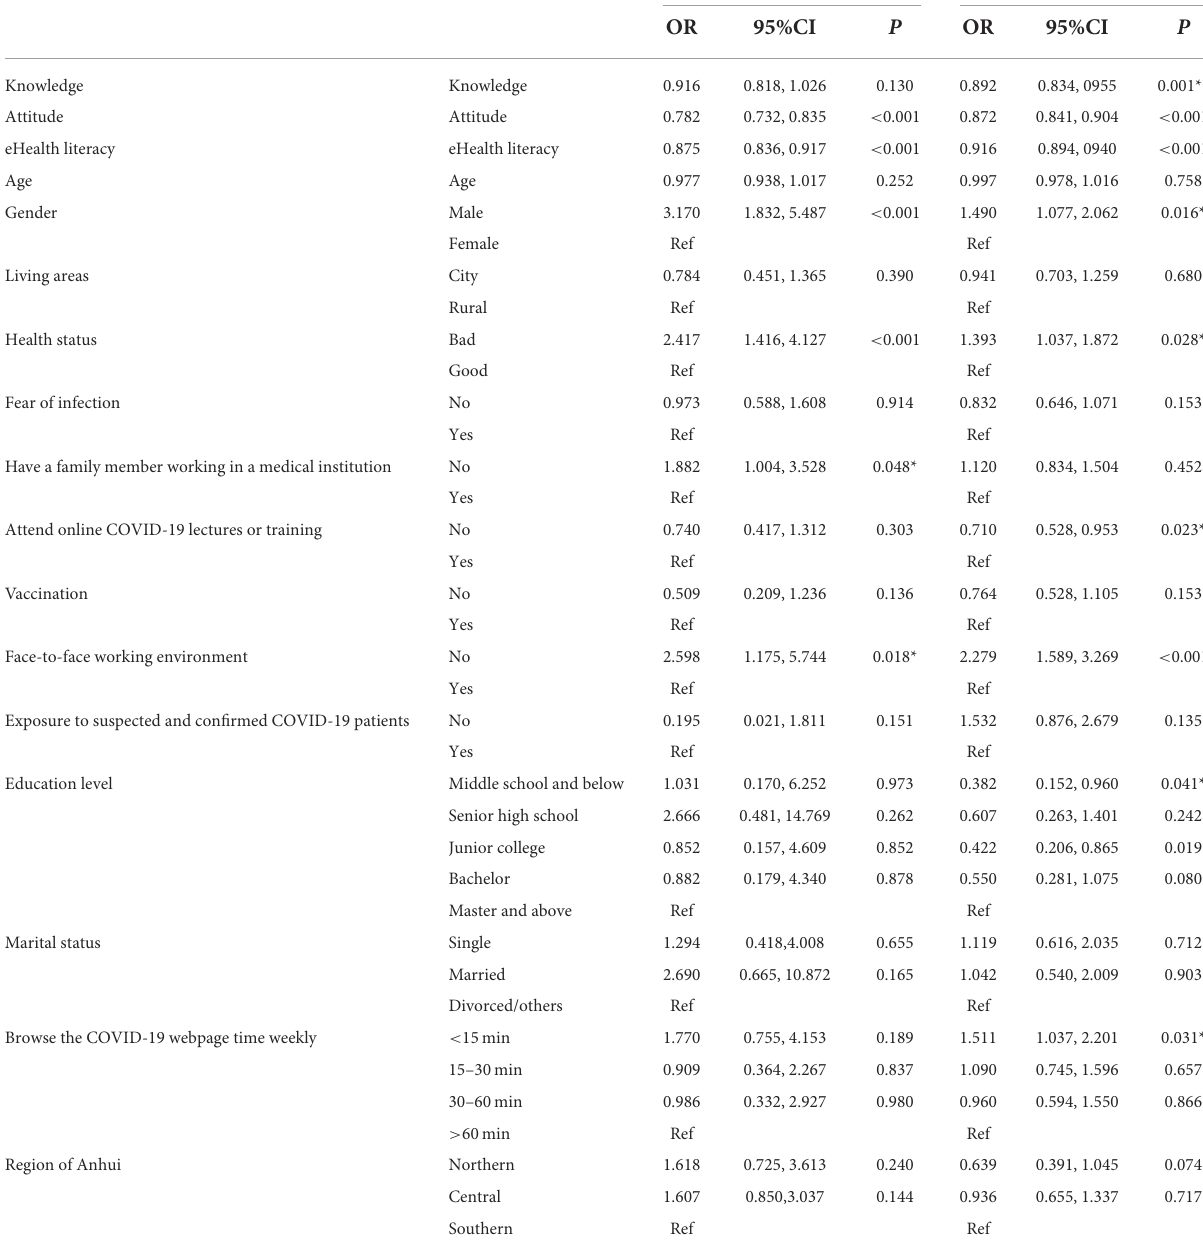
TABLE 6 Multinomial logistic regression analysis of the factors affecting preventive behavior level toward COVID-19 among the nursing students ( N =